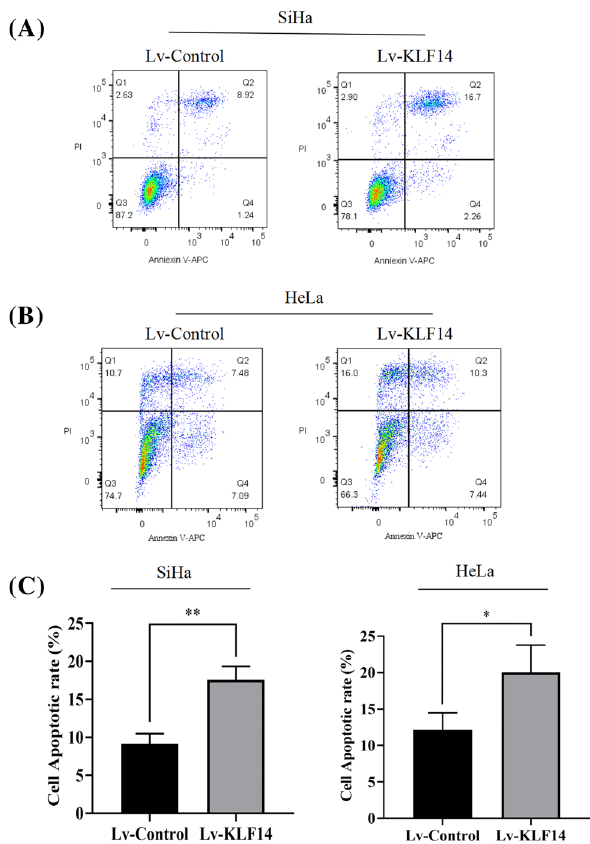
Fig. 4 KLF14 promotes cervi- cal cancer cell apoptosis. A Flow cytometry was per- formed to detect apoptosis, and the results showed that the apoptosis rate of SiHa cells in the Lv-KLF14 group was higher than that of SiHa cells in the Lv-control group. B The apoptosis rate of HeLa cells in the Lv-KLF14 group was higher than that of HeLa cells in the Lv-control group. C Quantitative statistics of the apoptosis rate of SiHa cells and HeLa cells. (*P < 0.05, **P <